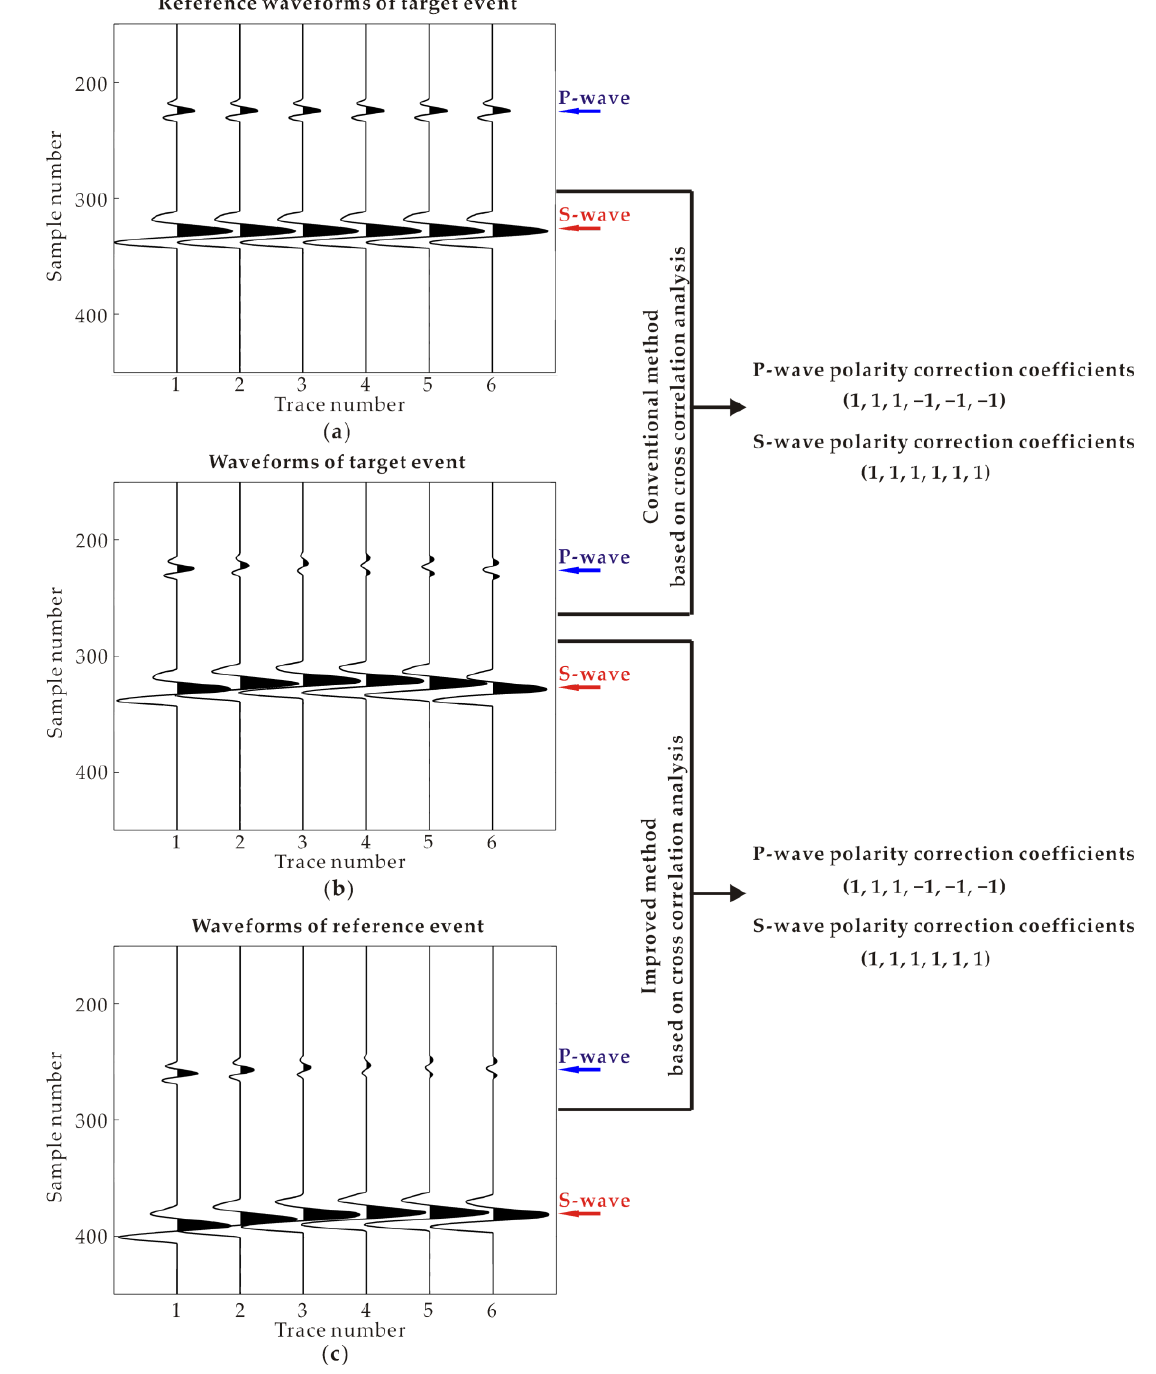
Figure 1. Illustration of polarity correction through conventional and improved methods based on cross correlation analysis. ( a ) Reference waveforms of target event, ( b ) waveforms of target event and ( c ) waveforms of reference event.